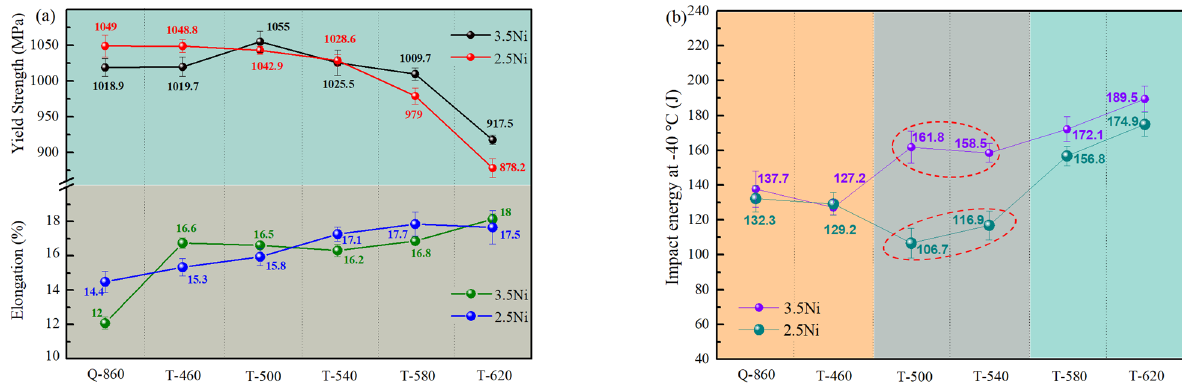
Figure 14. The mechanical properties of experimental steels. ( a ) Tensile properties at room tempera- ture. ( b ) Cryogenic impact properties.